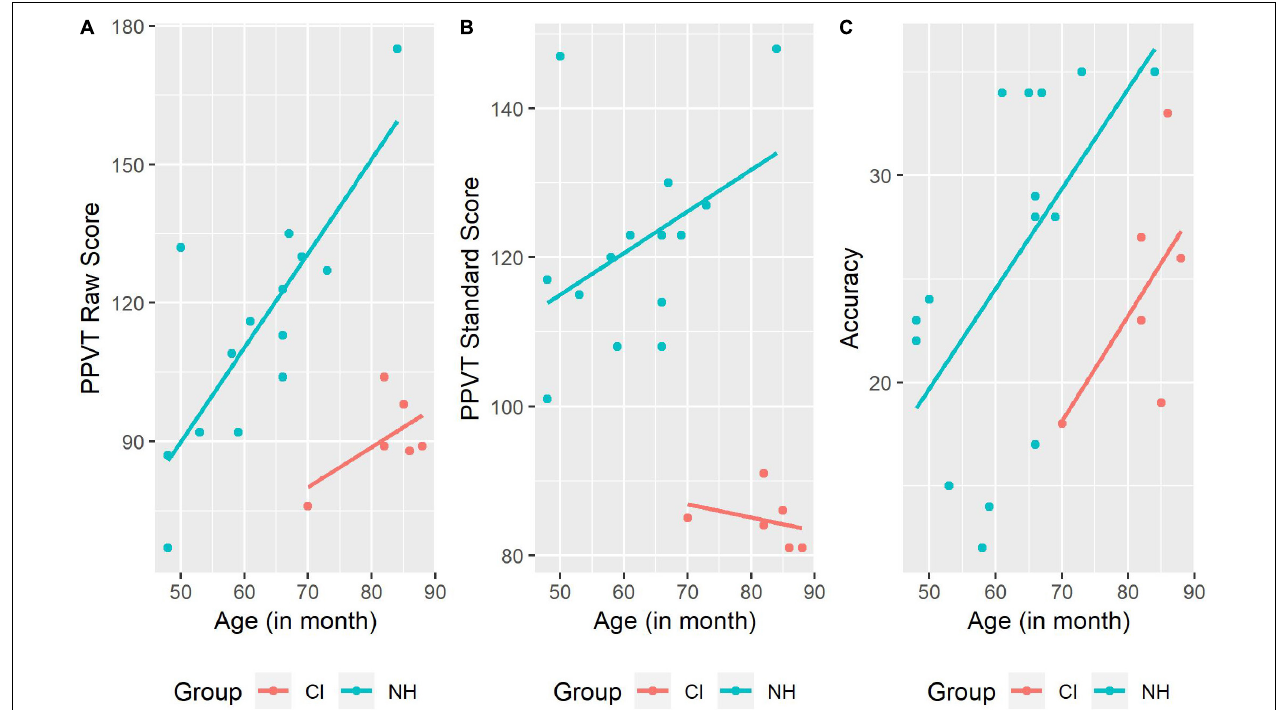
FIGURE 2 | Relationship between chronological age and PPVT raw score (A) , PPVT standard score (B) , and accuracy performance in the rhyme oddity task (C)